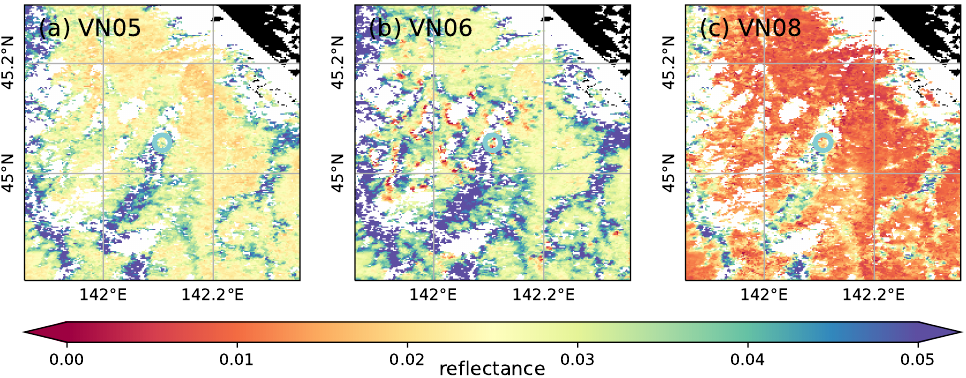
Figure 17. The spatial distribution of ( a ) VN 05 satellite , ( b ) VN 06 satellite , and ( c ) VN 08 satellite on 8 August 2018 (DOY = 220) around TSE. The range of each map is the same as that of Figure 16b–d. All maps are screened with the QA flag. The cyan circles in each figure indicate the location of